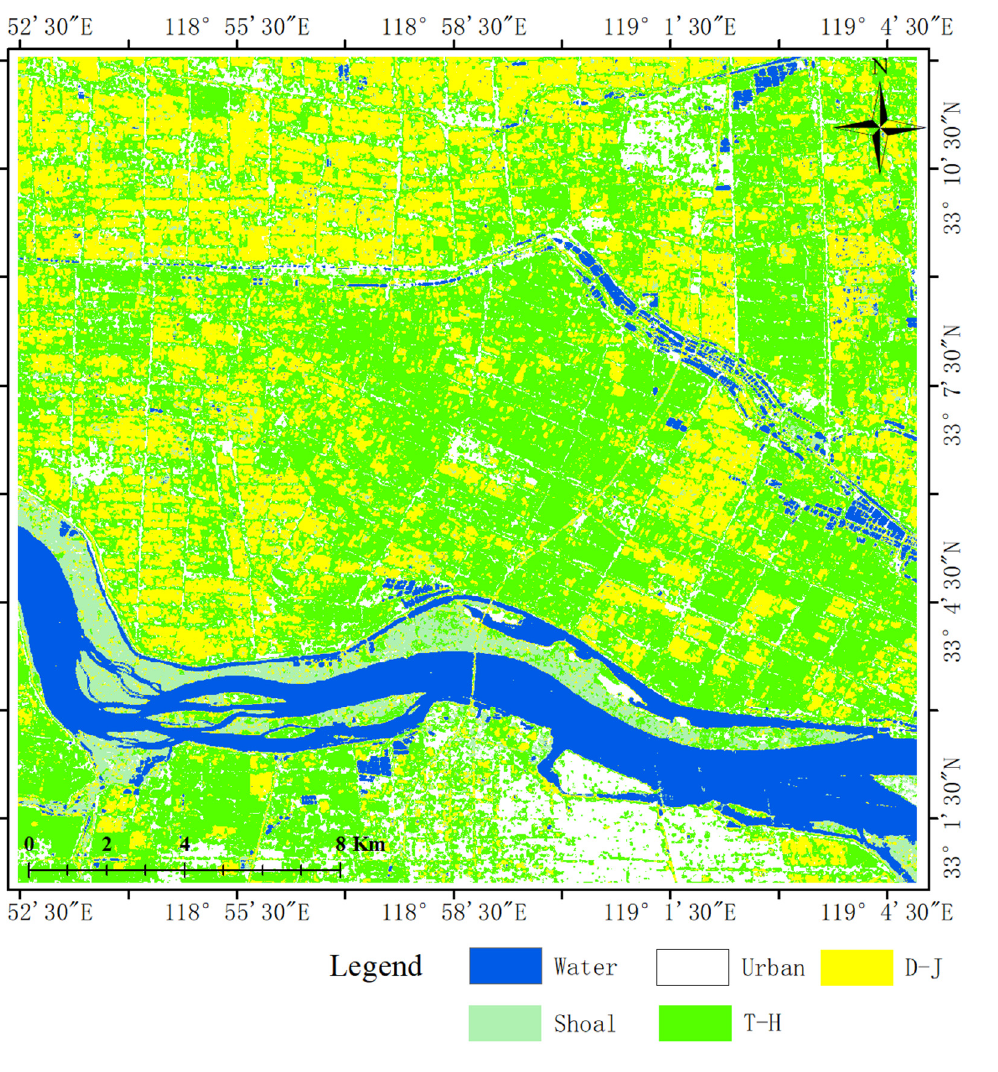
Figure 13. Classification result based on decision tree model.